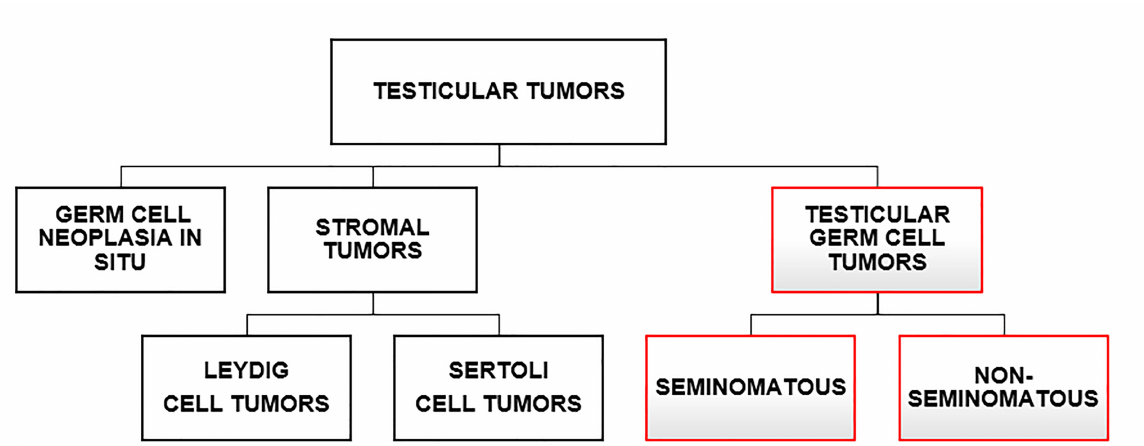
Figure 1 - Testicular tumor